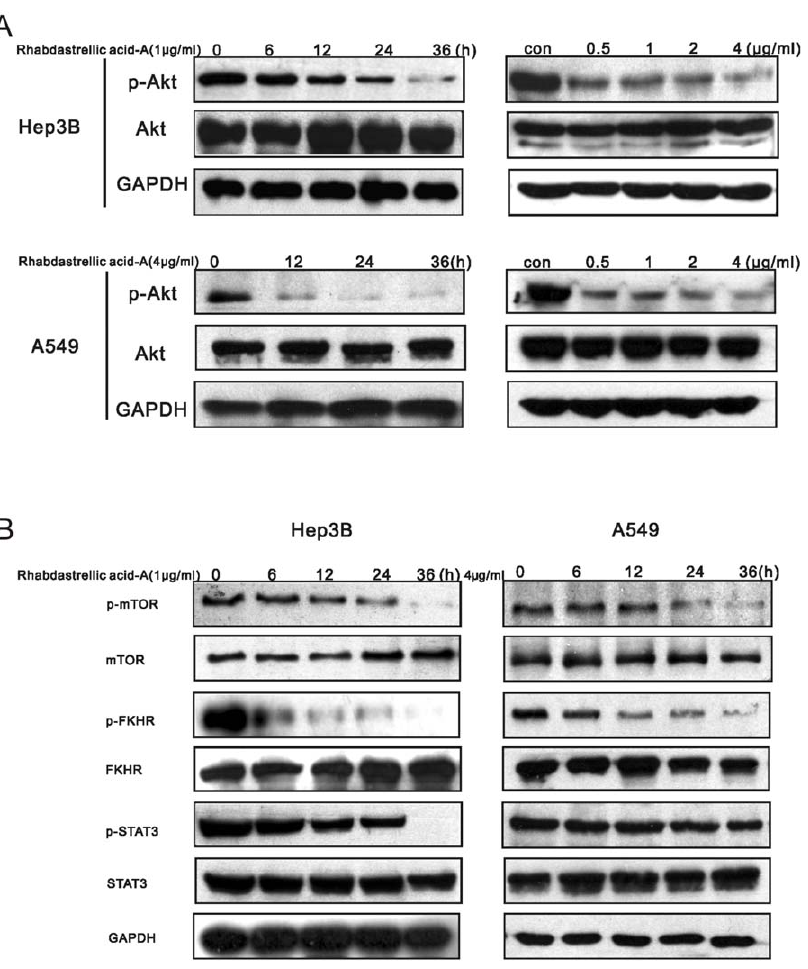
Figure 6. The effect of Rhabdastrellic acid-A on Akt pathway in Hep3B and A549 cells. Hep3B and A549 cells were treated with Rhabdastrellic acid-A in the indicated concentrations for 36 h or treated with 1 m g/mL or 4 m g/mL Rhabdastrellic acid-A for the indicated times. A. Cells were sequentially harvested and lysed. cell lysates were analyzed by immunoblotting with phospho-Akt or Akt antibodies. B. mTOR, phospho- mTOR, FKHR, phospho-FKHR, STAT3 and phospho-STAT3 were analyzed by immunoblotting. The experiment was performed 3 times.